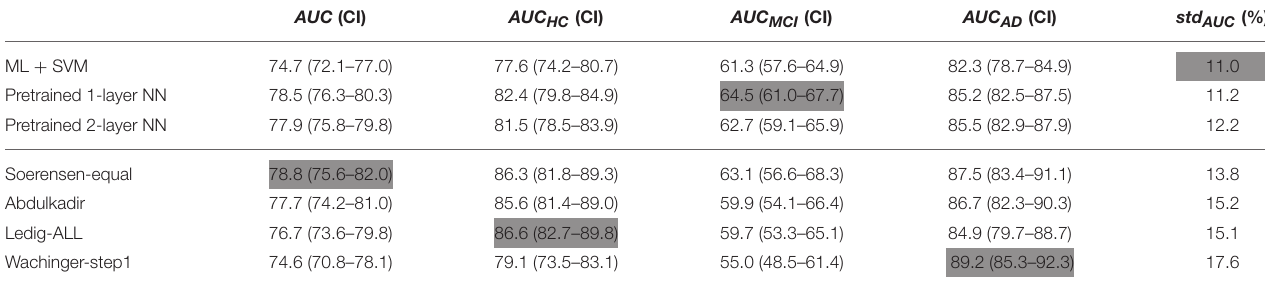
TABLE 6 | Area under the ROC performance measures for the multi-class scenario following the validation scheme in Bron et al.